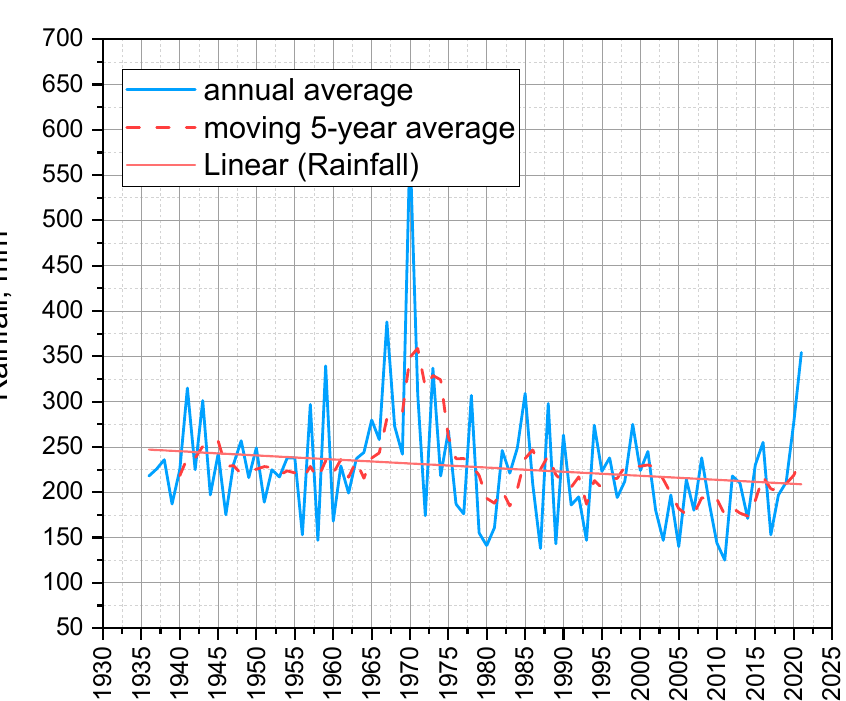
Figure 3. Rainfall trend at the Novoselenginsk station for the period of 1936–2021.